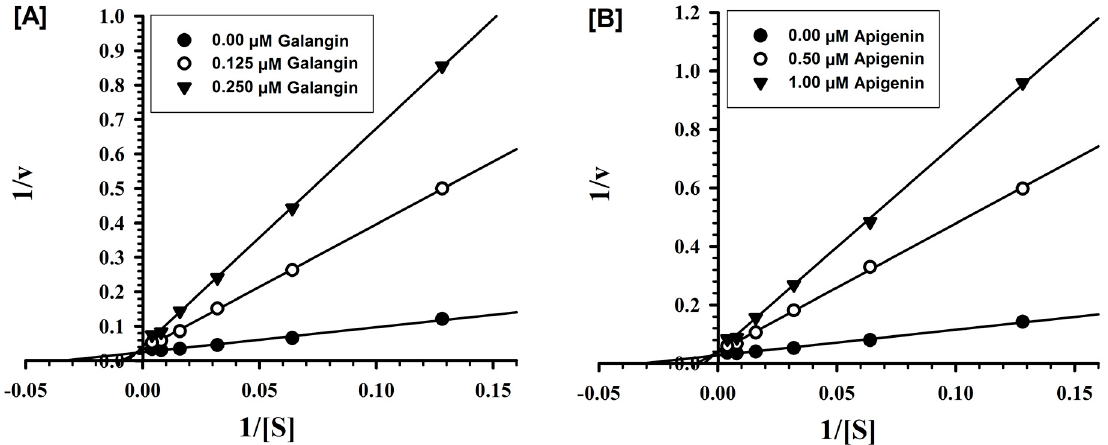
Figure 2. Kinetic characteristics of inhibition of recombinant human MAO-A with [ A ] galangin and [ B ] apigenin; V = nmoles/min/mg protein and S = substrate kynuramine concentration ( μ M).